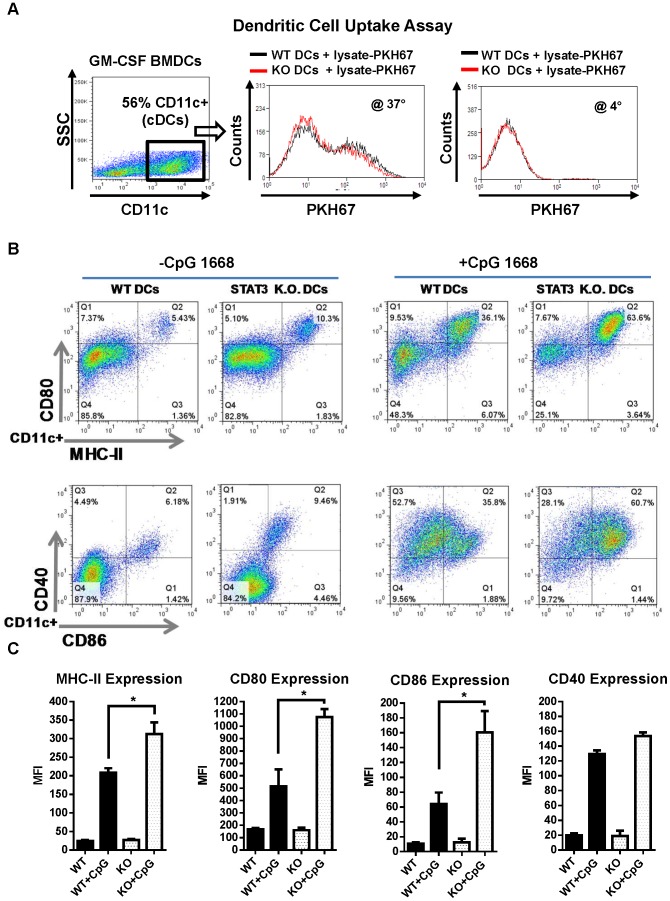
Role of STAT3 signaling on phagocytic activity and DCs' maturation.
A. Uptake of fluorescently labeled tumor cell remnants were used as a measure of DC phagocytosis. WT and STAT3−/− bone marrow cells were cultured in the presence of GM-CSF (40 ng/ml) for 6 days to expand the DC pool. BMDCs were then cultured in the presence of PKH-67 labeled GL26 tumor cell lysate for 14 hours then analyzed by flow cytometry. Fluorescence intensity of PKH-67 in CD11c+ cells is presented as histograms and indicative of active uptake. Phagocytosis assays were also performed at 4°C to control for uptake by means of passive diffusion. B. WT and STAT3 deficient BMDCs were matured in vitro using CpG. Cell surface expression of MHC-II, CD80, CD86, and CD40 was evaluated in CD11c+ GM-CSF derived DCs after an 18 hour stimulation with CpG 1668 (500 ng/ml). C. The median fluorescence intensity of maturation markers was quantified in two independent bone marrow cultures (*, p<0.05; two-tail students t-test).